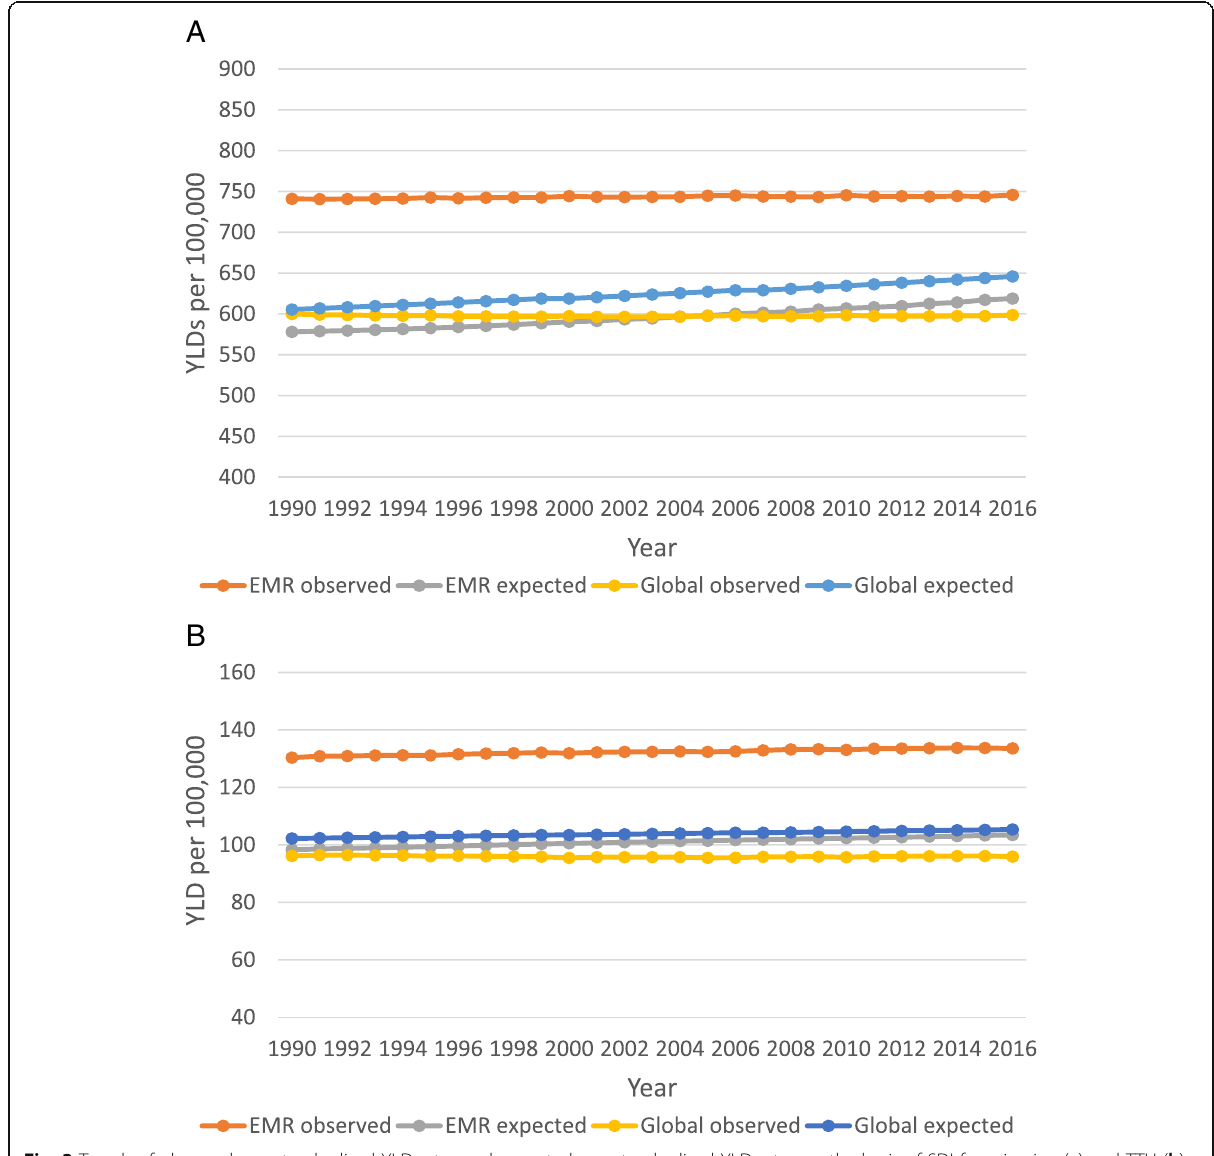
Fig. 3 Trends of observed age-standardised YLD rates and expected age-standardised YLD rates on the basis of SDI for migraine ( a ) and TTH ( b ) in the EMR and globally. Abbreviations: TTH, tension-type headache; EMR, Eastern Mediterranean